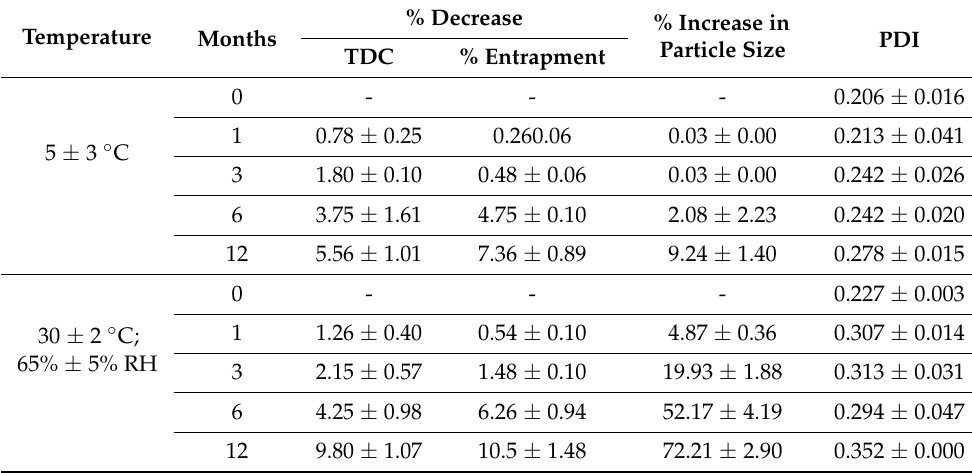
Table 6. Stability studies on optimized CSLN formulation ( n